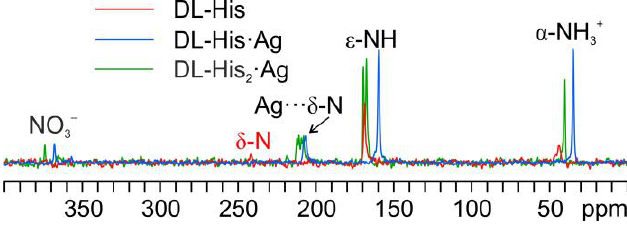
Figure 14. Overlay of a detail of the 15 N CPMAS spectra of DL-His 2 · Ag (in green), DL-His · Ag (in blue), and pure DL-His (in